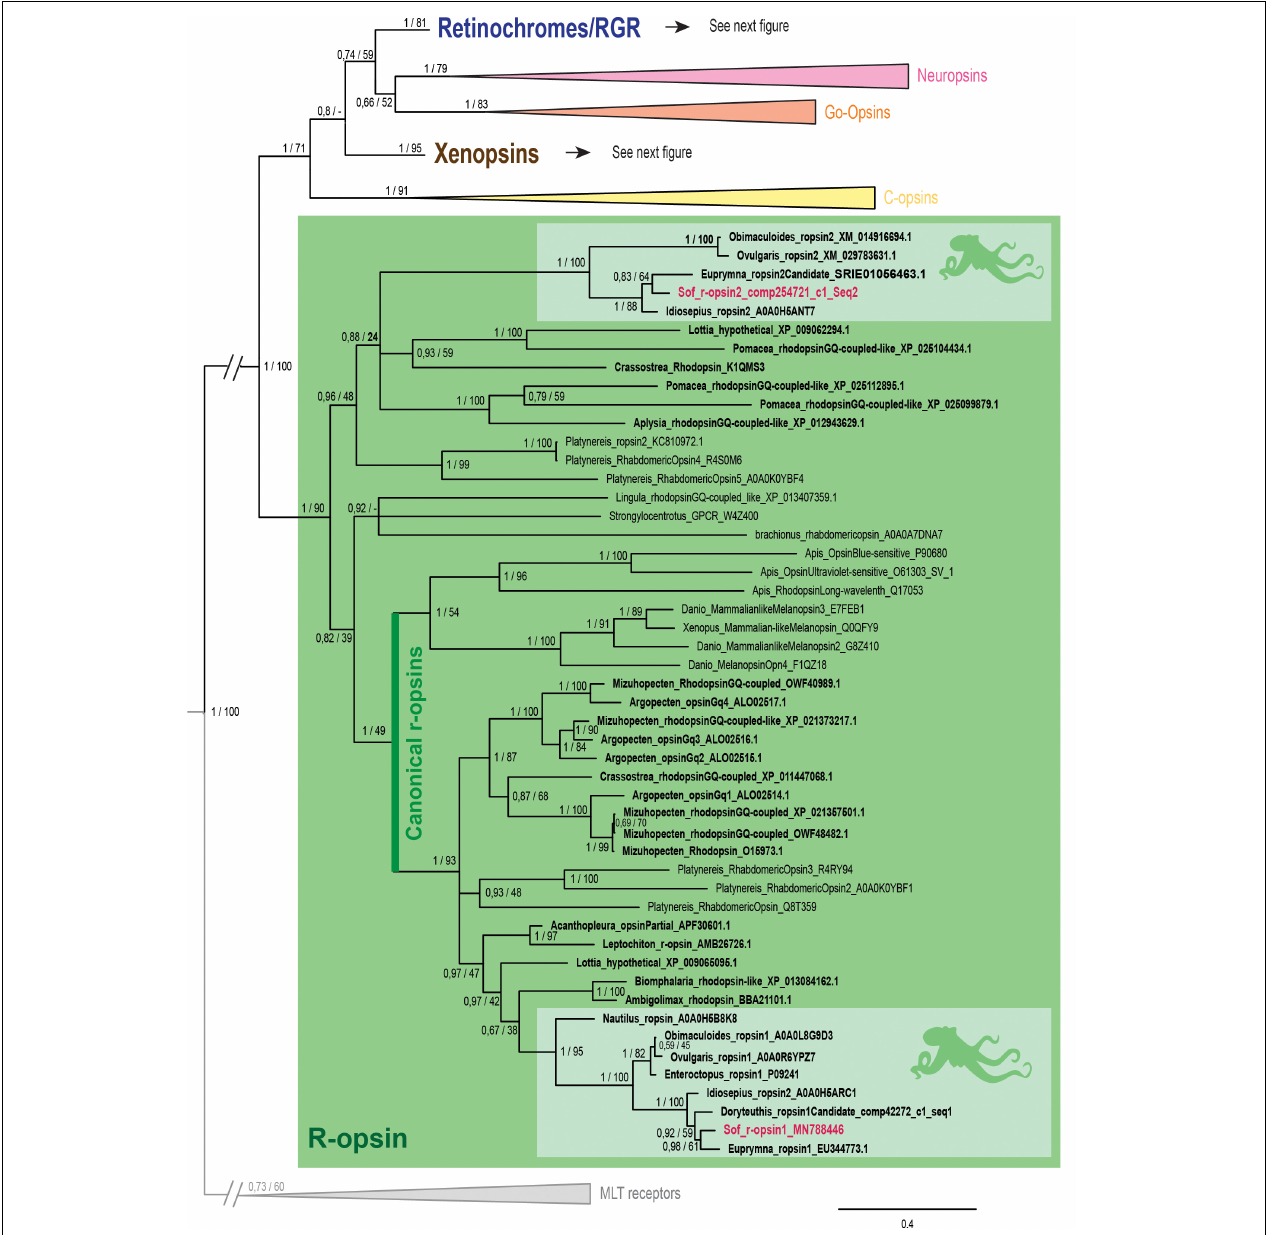
FIGURE 2 | Opsin phylogeny with a focus on r-opsins. Phylogenetic analysis of 139 sequences of 311 amino acids generated in Bayesian Inference (MrBayes v3.2.7a). 6 main groups of opsins are retrieved: retinochromes (blue), neuropsins (red), Go-opsins (orange), xenopsins (brown), c-opsins (yellow) and r-opsins (green). Sequences from S. officinalis are in red, sequences from other molluscs are in bold and outgroups (Melatonine receptors (MLT)) are in gray. Dopamine receptors used for rooting the tree are not shown on the figure. Nodes labels are posterior probabilities and bootstrap values (PP/BS). Lighter boxes with cephalopod silhouette [modified from Stöger et al. (2013)] represent groups of cephalopod sequences. The branch from the root to the ingroups and outgroups were shortened for more lisibility